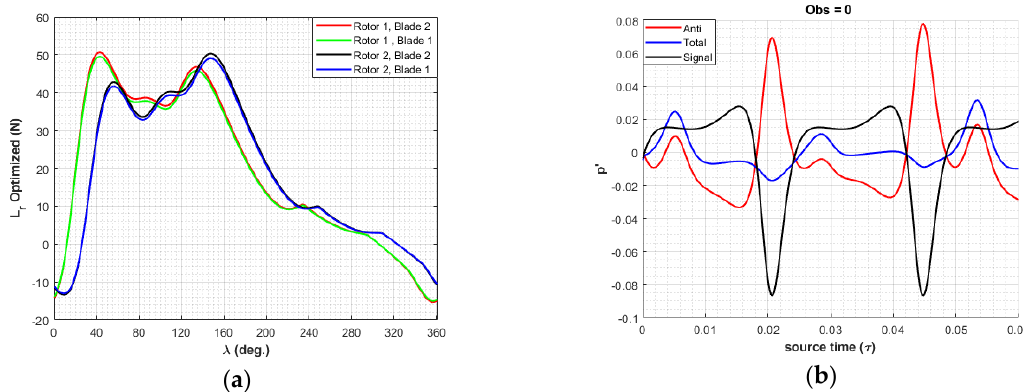
Figure 13. ( a ) Optimized Loading Solution, L r , for each blade; ( b ) Total Noise at target observer, ψ obs = 0 o .